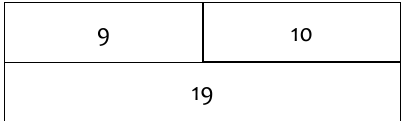
Figure 7: Sam’s solution to 9 and 10 part-part